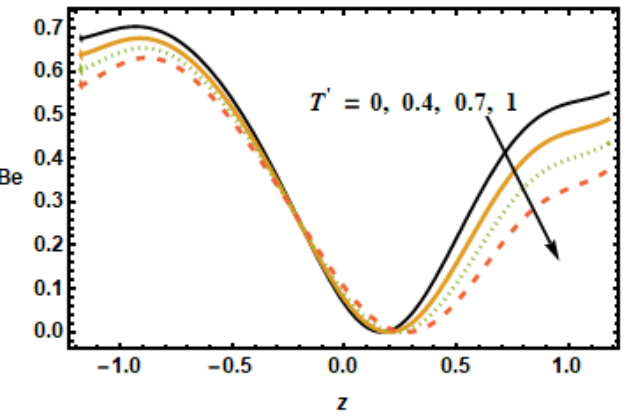
Figure 28. Effects of radiation parameter Rd on Be .